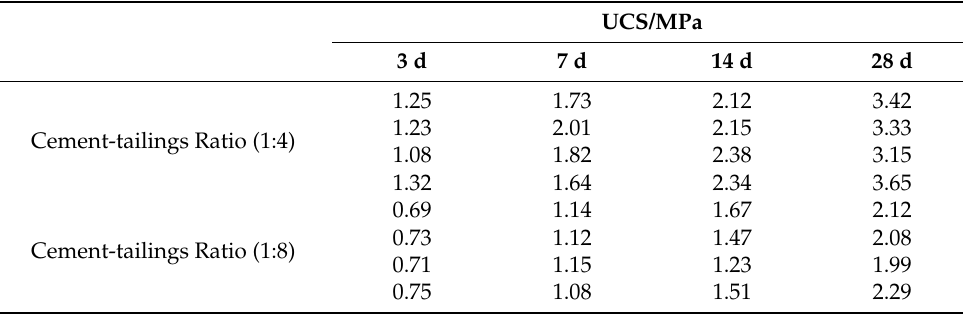
Figure 8. Attenuation at different guided wave frequencies; ( a ) sample A; ( b ) sample B. Table 2. Uniaxial compressive strength of